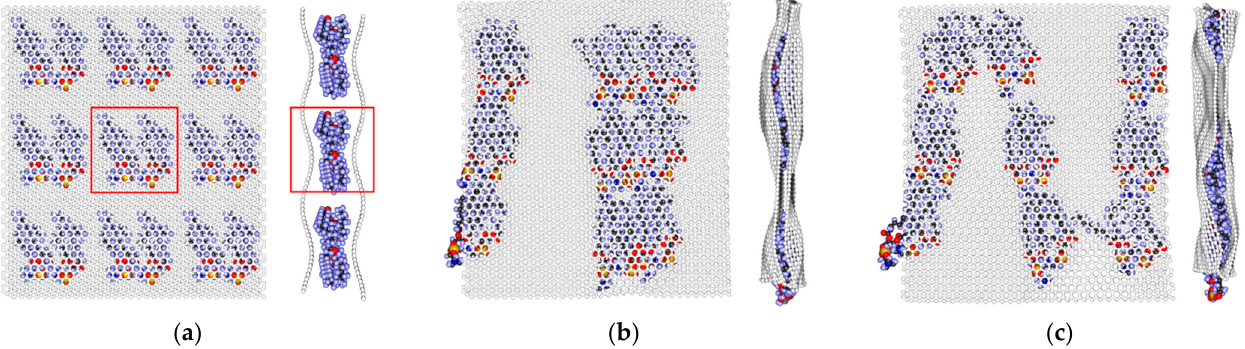
Figure 1. Atomic structure of the graphene/dipalmitoylphosphatidylcholine (DPPC) composite: ( a ) before the optimization; ( b ) type I after the optimization; and ( c ) type II after the optimization. The supercell obtained by the self-consistent charge density functional tight-binding (SCC DFTB) 2 method is highlighted by the red box. Graphene atoms are grey, phosphorous—yellow, nitrogen—blue, oxygen—red, carbon in phospholipid—black, and hydrogen—blue.